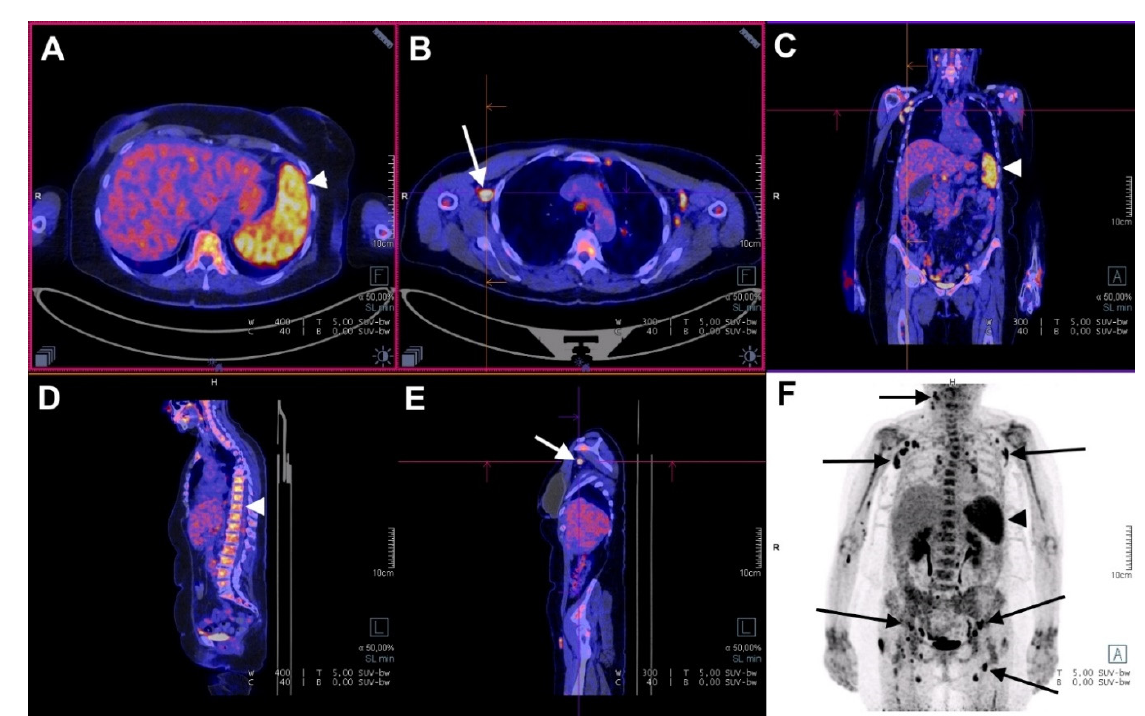
Figure 1. 18F-FDG PET/CT in a case of AOSD with a monocyclic course. A 63-year-old woman presented with a fever up to 39.6 °C, asthenia, polyarthralgia, sore throat, and skin rash. Arrowheads show 18 F-FDG accumulation in the spleen